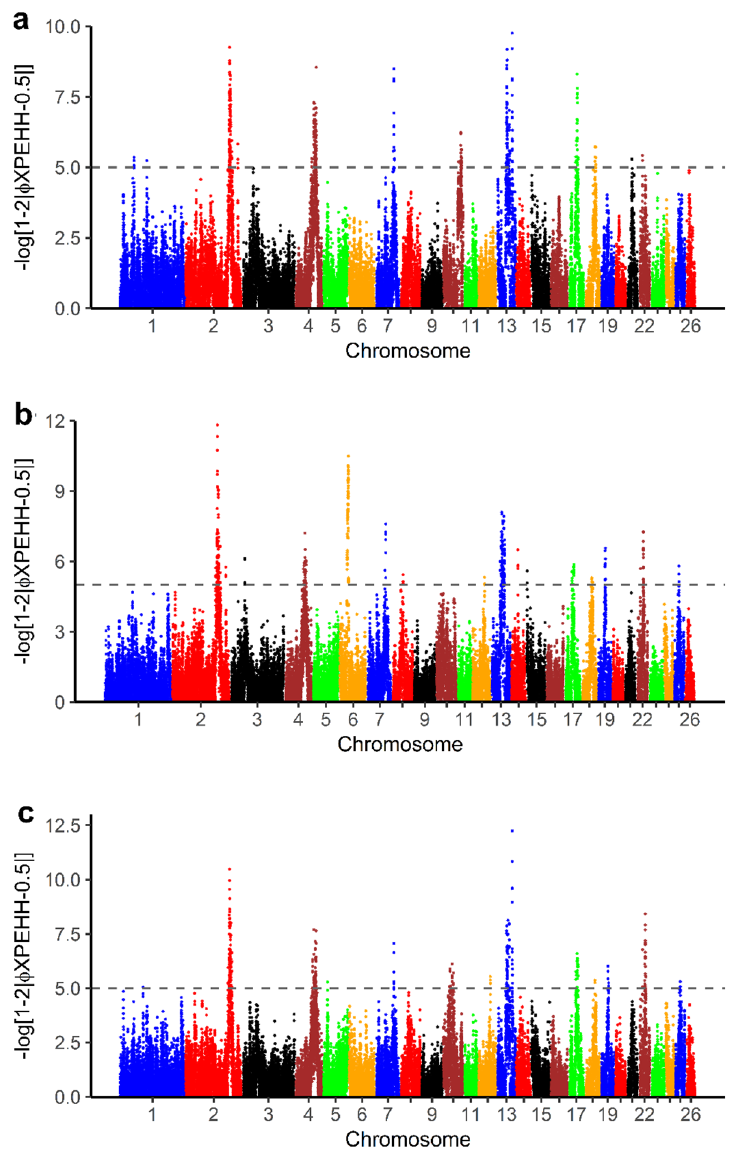
Figure 7. Manhattan plots for cross-population extended haplotype homozygosity (XPEHH) analyses of ( a ) Balusha vs. Bardhoka, ( b ) Balusha vs. Istrian and ( c ) Balusha vs. Ruda. The dashed lines represent the threshold level for significance at pXPEHH ≥ 5 equivalent to a p -value < 0.00001. Common selection signals were considered as signatures of selection specific for Balusha. Overall they are most obvious in chromosomes 2, 4 and 13. Table 4. Enriched GO TERMS determined by DAVID from genes identified in selection regions specific to the BAL breed using XPEHH. Please note that GOTERM_MF refers to molecular function